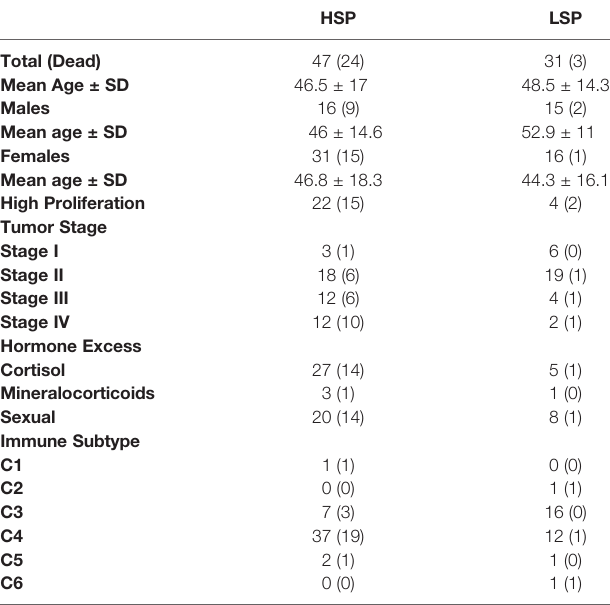
ThetotalnumberofpatientsforeachclinicalcategoryfortheLowSteroidPhenotype(LSP) and High Steroid Phenotype (HSP) is shown with the number of dead patients in parenthesis. The mean age of participants with the standard deviation (SD) is shown